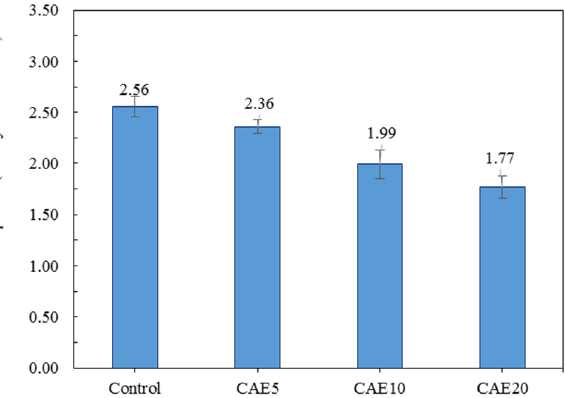
Figure 7. Water absorption values of the hybrid alkali-activated mortars with different CAE contents.